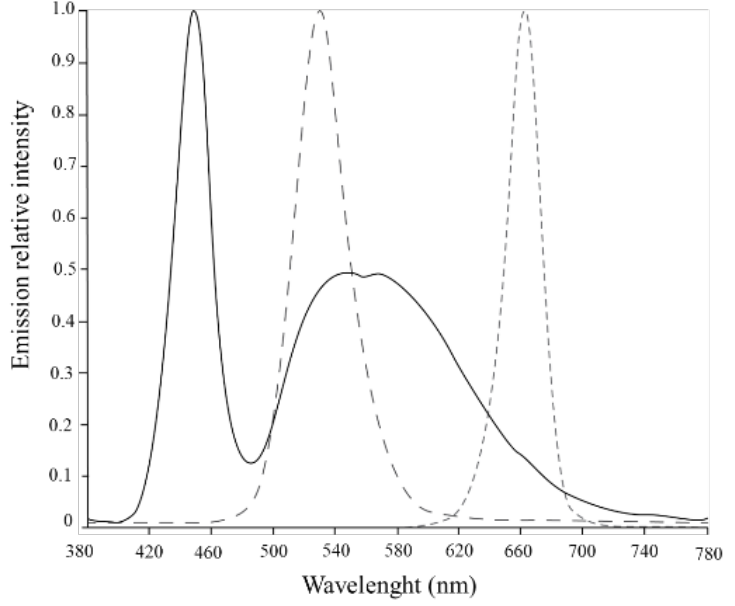
Figure 2. Emission relative intensity of LED spectra used in this study: white ( ); green ( ) and red ( ).